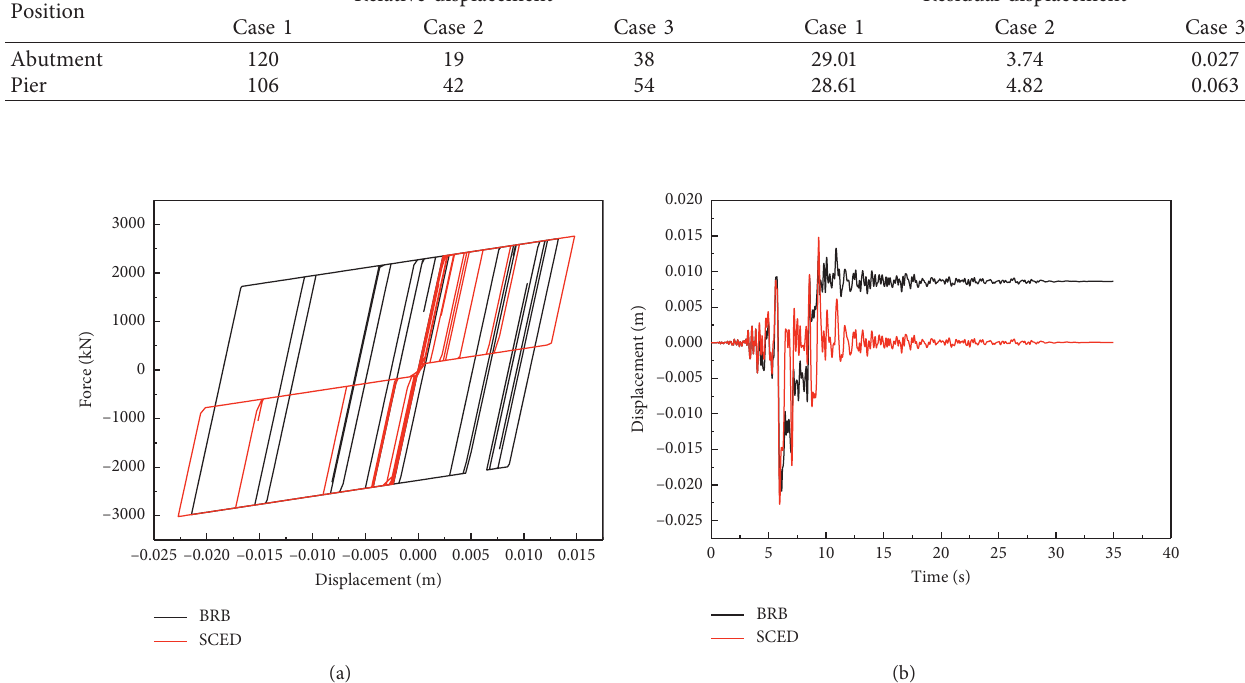
Figure 13: Hysteretic curve and displacement time-history curves of braces: (a) hysteresis curve; (b) displacement time-history